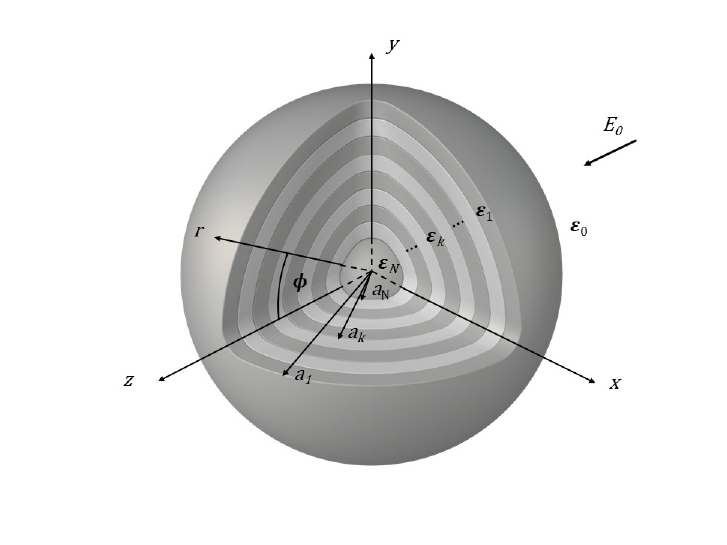
Figure 1. Geometry represents the anisotropic multilayer sphere immersed in free